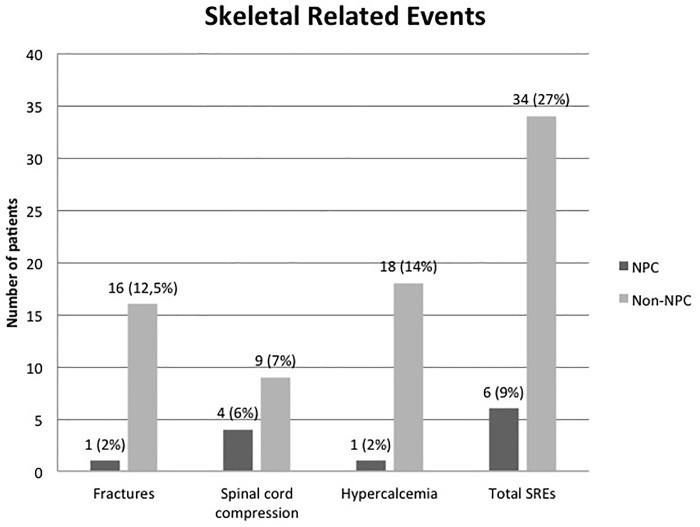
SRE frequency and distribution in NPC and non-NPC patients.